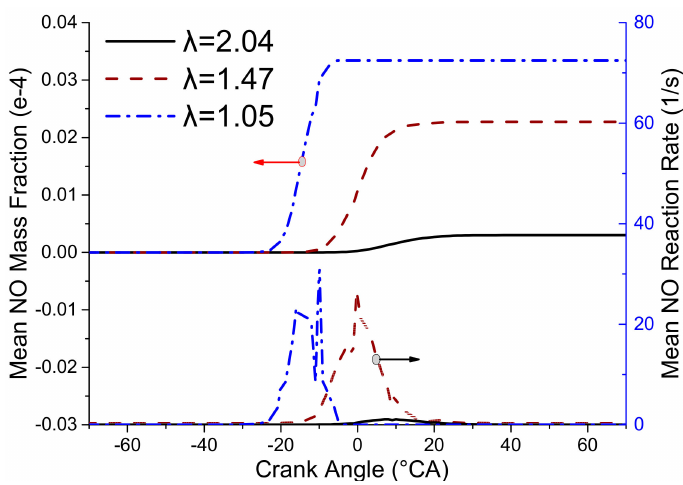
Figure 6. Di ff erent equivalent ratios of the mass fraction and NO reaction rate.